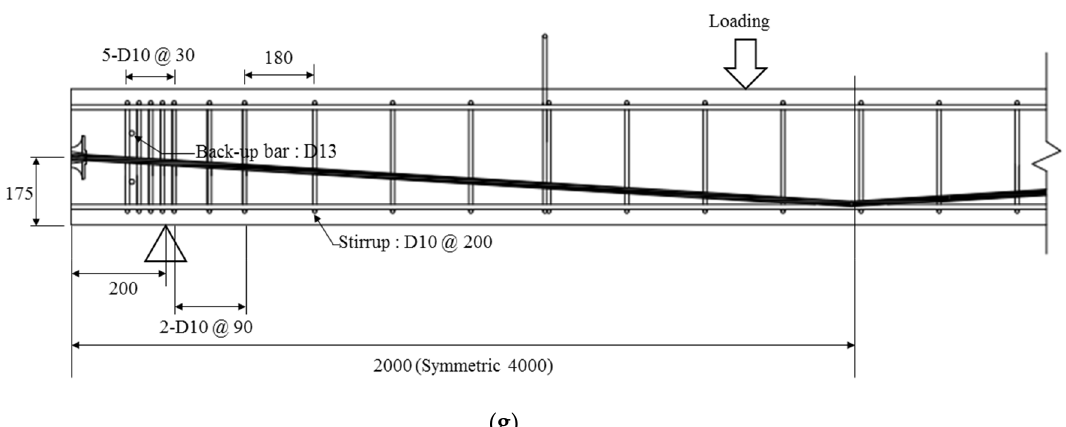
Figure 3. Details of specimens(mm): ( a ) shape of anchorage; ( b ) top view of RH-2 and CH-2; ( c ) top view of RH-3 and CH-3; ( d ) top view of RH-4 and CH-4; ( e ) side view of specimens reinforced with hair pins; ( f ) side view of specimens reinforced with Type 1 stirrups; ( g ) side view of specimens reinforced with Type 2 stirrups.